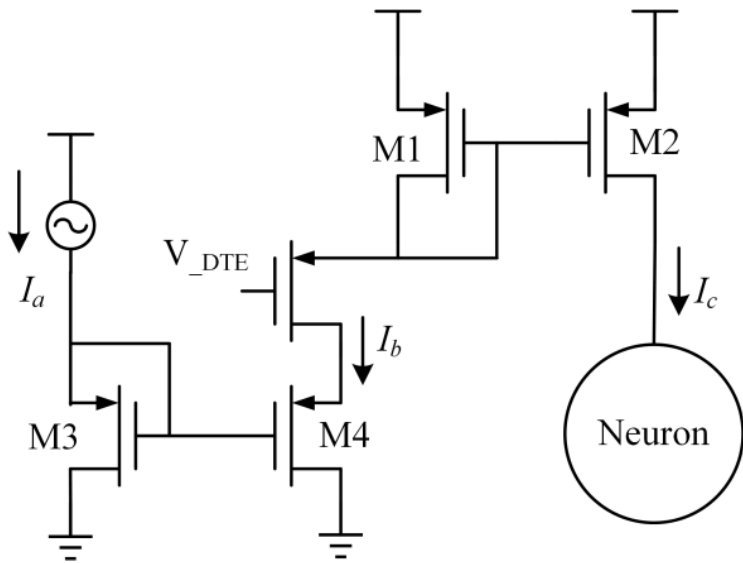
Figure 14. Radiation tolerance circuit for spike frequency decay.